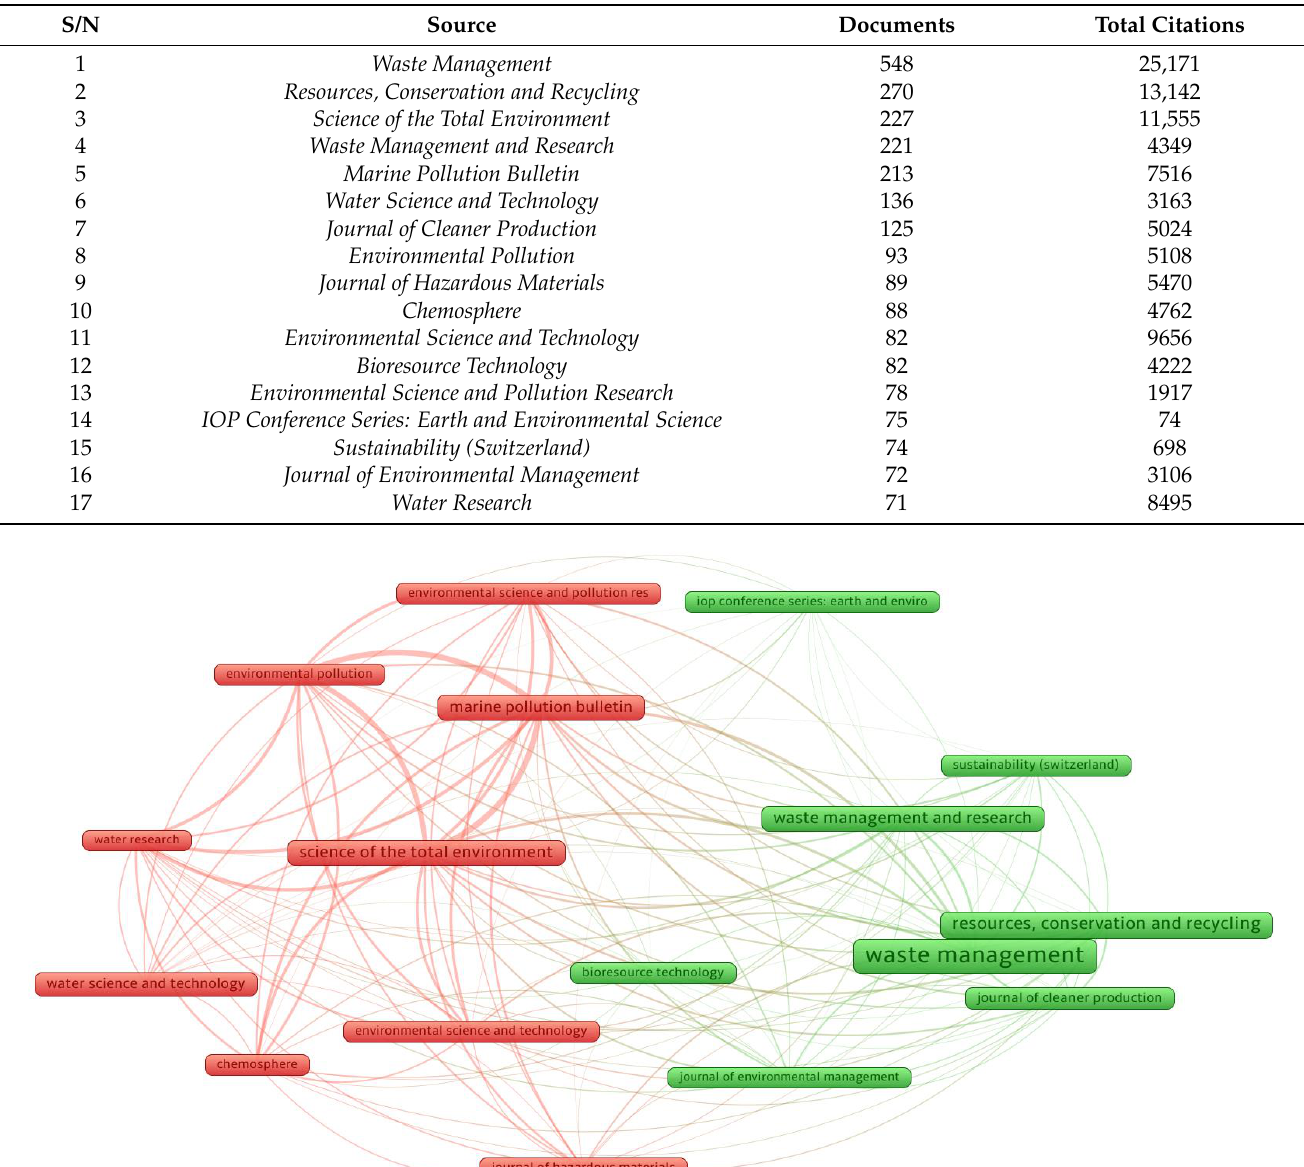
Table 1. Sources of publications with a minimum of 71 papers in the related field up through 2021.